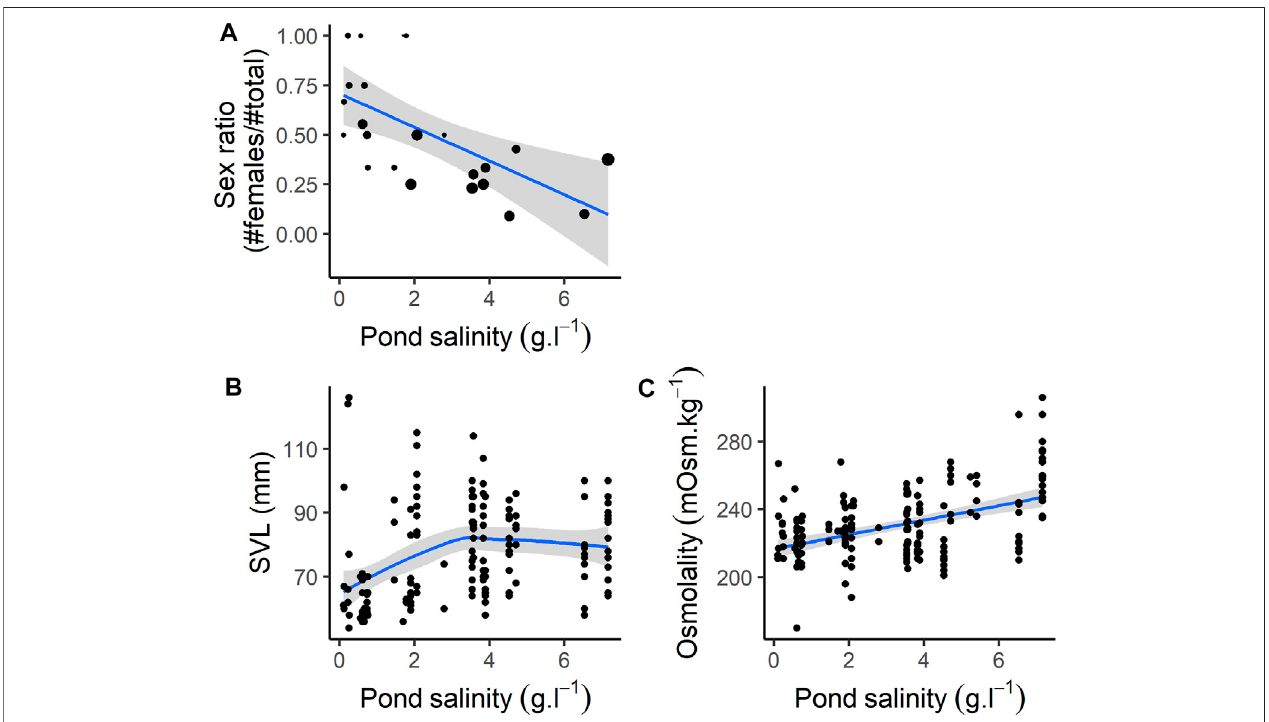
FIGURE1| Individualcharacteristicsaccordingtopondsalinity. (A) Sexratio(notethatsizeofthedotsareproportionaltothesamplesize,rangingfrom1to16,see Supplementary Appendix B ), (B) SVL (size, mm), (C) Osmolality.